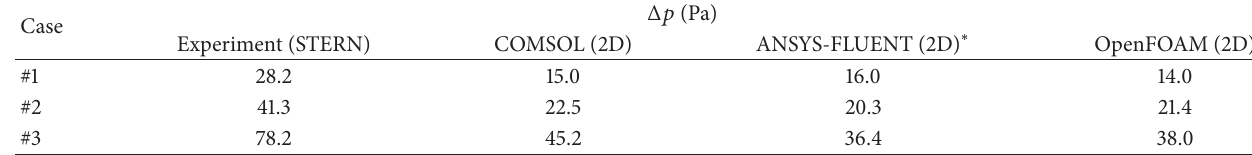
Table 3: Comparison of pressure drop for the STERN laboratory experiment, 2D.